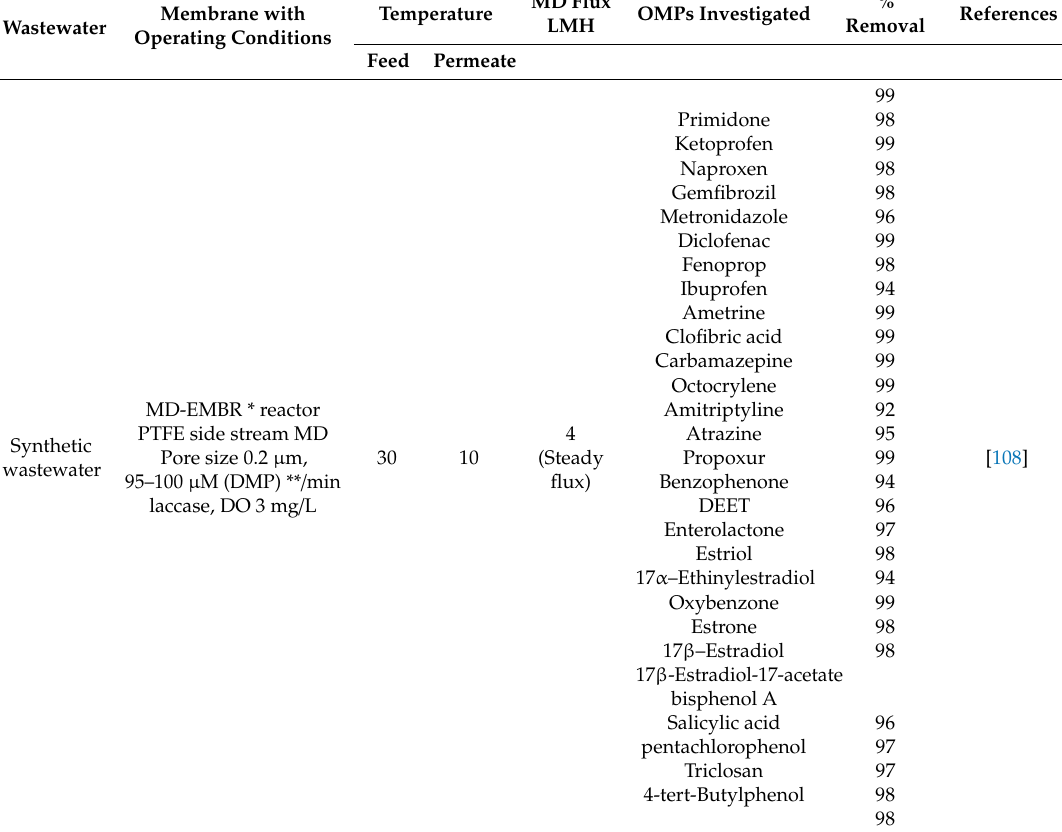
Table5. RemovalofOMPsinmembranedistillationbioreactor(MDBRs)andmajoroperatingconditions.